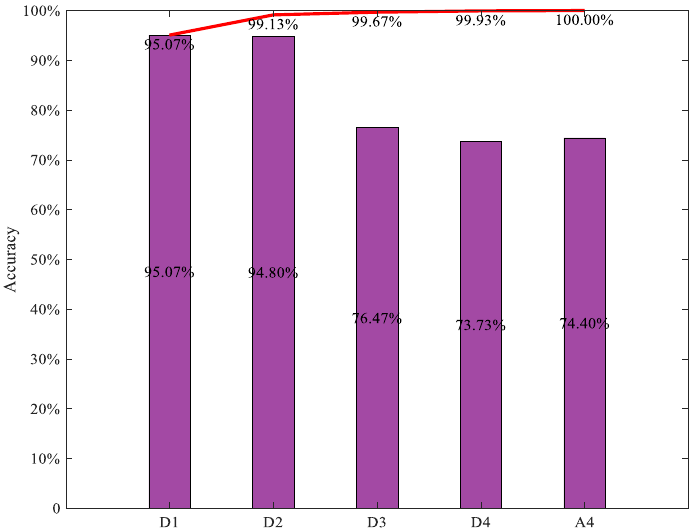
Figure 13. Diagnosis accuracy of the integrated ViT models with first n ViT. The histogram indicates the diagnosis accuracy of the individual ViT with different TFR maps respectively, the red curve indicates the diagnostic accuracy of the integrated ViT model with the first n TFR maps of subsignals.